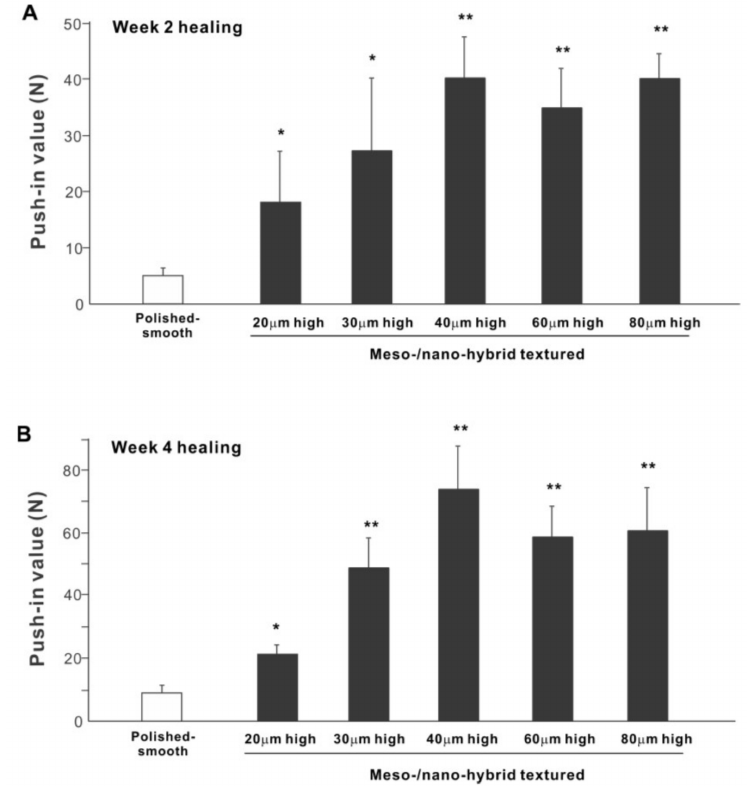
Figure 10. The biomechanical push-in test in the rat femur model at week 2 ( A ) and 4 ( B ) post- implantation. * p < 0.05, ** p < 0.01, statistically significant difference compared with a polished- smooth surface.